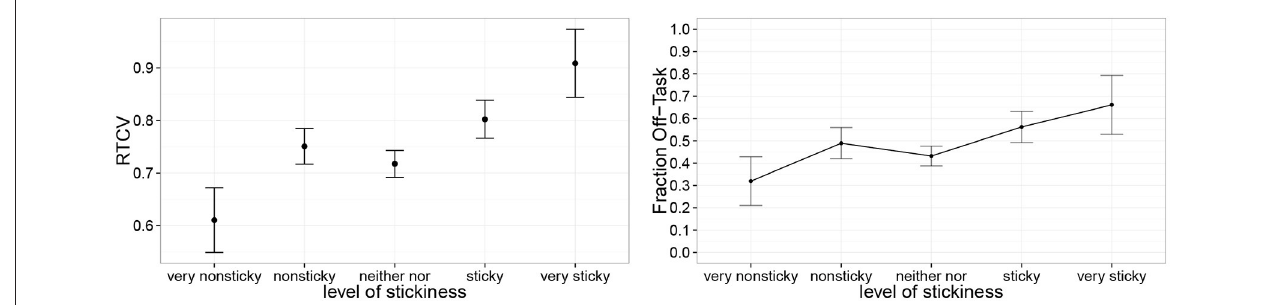
FIGURE 5 | Off-task thinking (right) and variability in response time (left) increases with self-reported thought stickiness. Error bars reflect standard